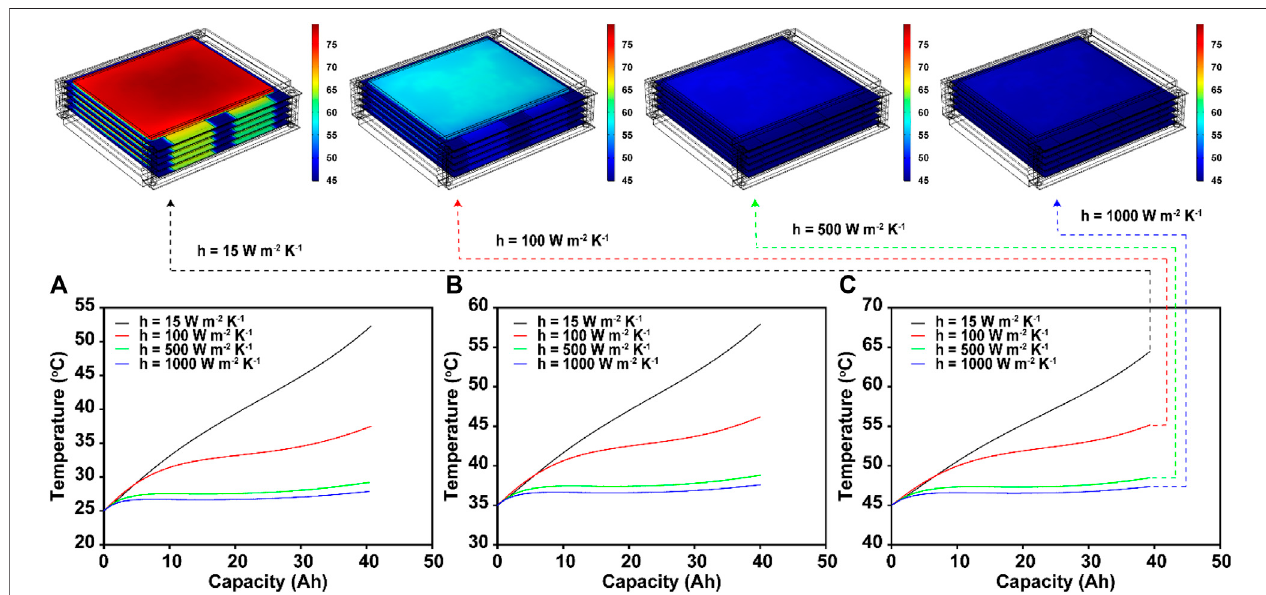
FIGURE 7 | Surface temperature changes of the modules with different heat transfer coef fi cients (15, 100, 500, and 1000 W m − 2 K − 1 ) at exterior temperatures of (A) 25 ° C, (B) 35 ° C, and (C) 45 ° C during 5C discharging (Top: overall temperature distributions of the module at 45 ° C).